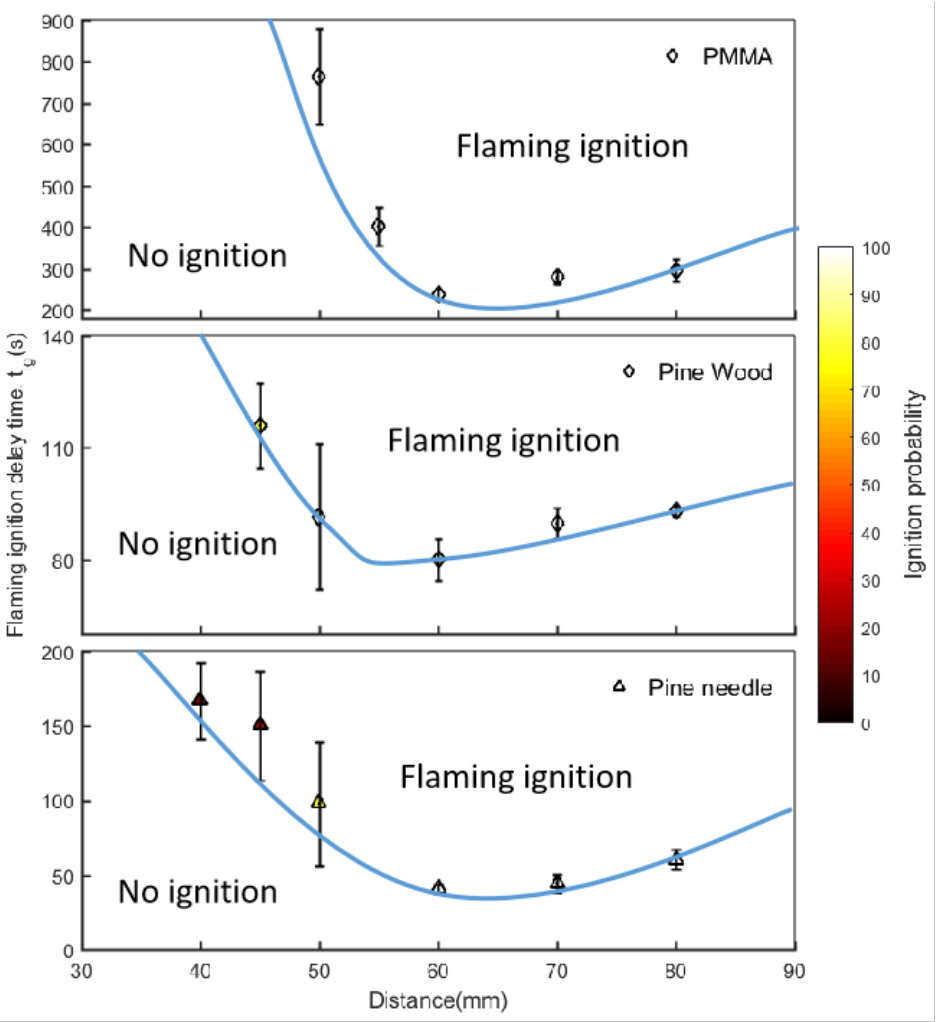
Figure 9. The ignition delay time of different types of fuels.